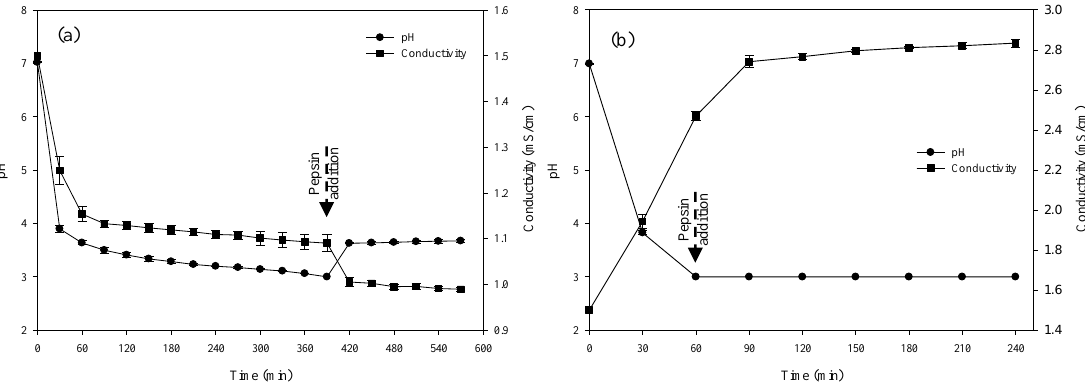
Figure 3. Evolution of pH and conductivity as a function of time during electro-acidification and hydrolysis in EDBM-MCP ( a ) and in EDBM-AEM ( b ).